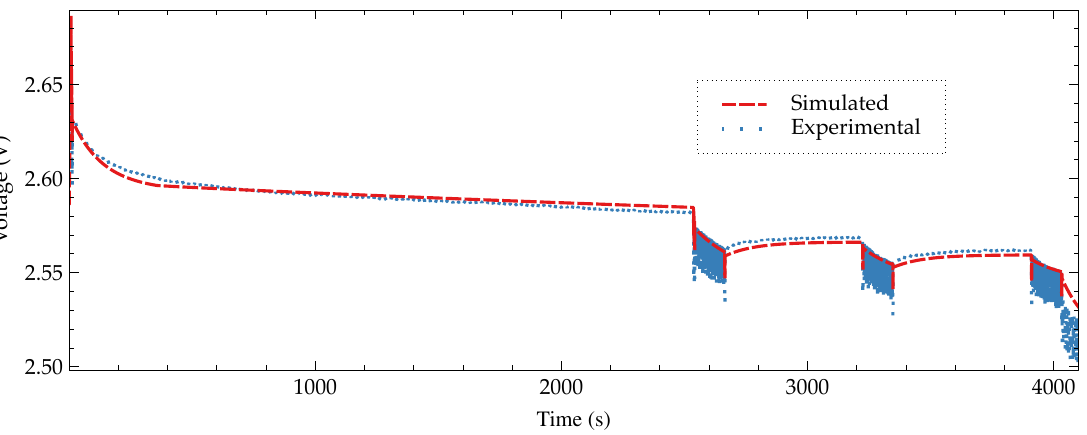
Figure 13. Comparison between simulation and real battery voltage for an experiment executing three identical measure- ments of